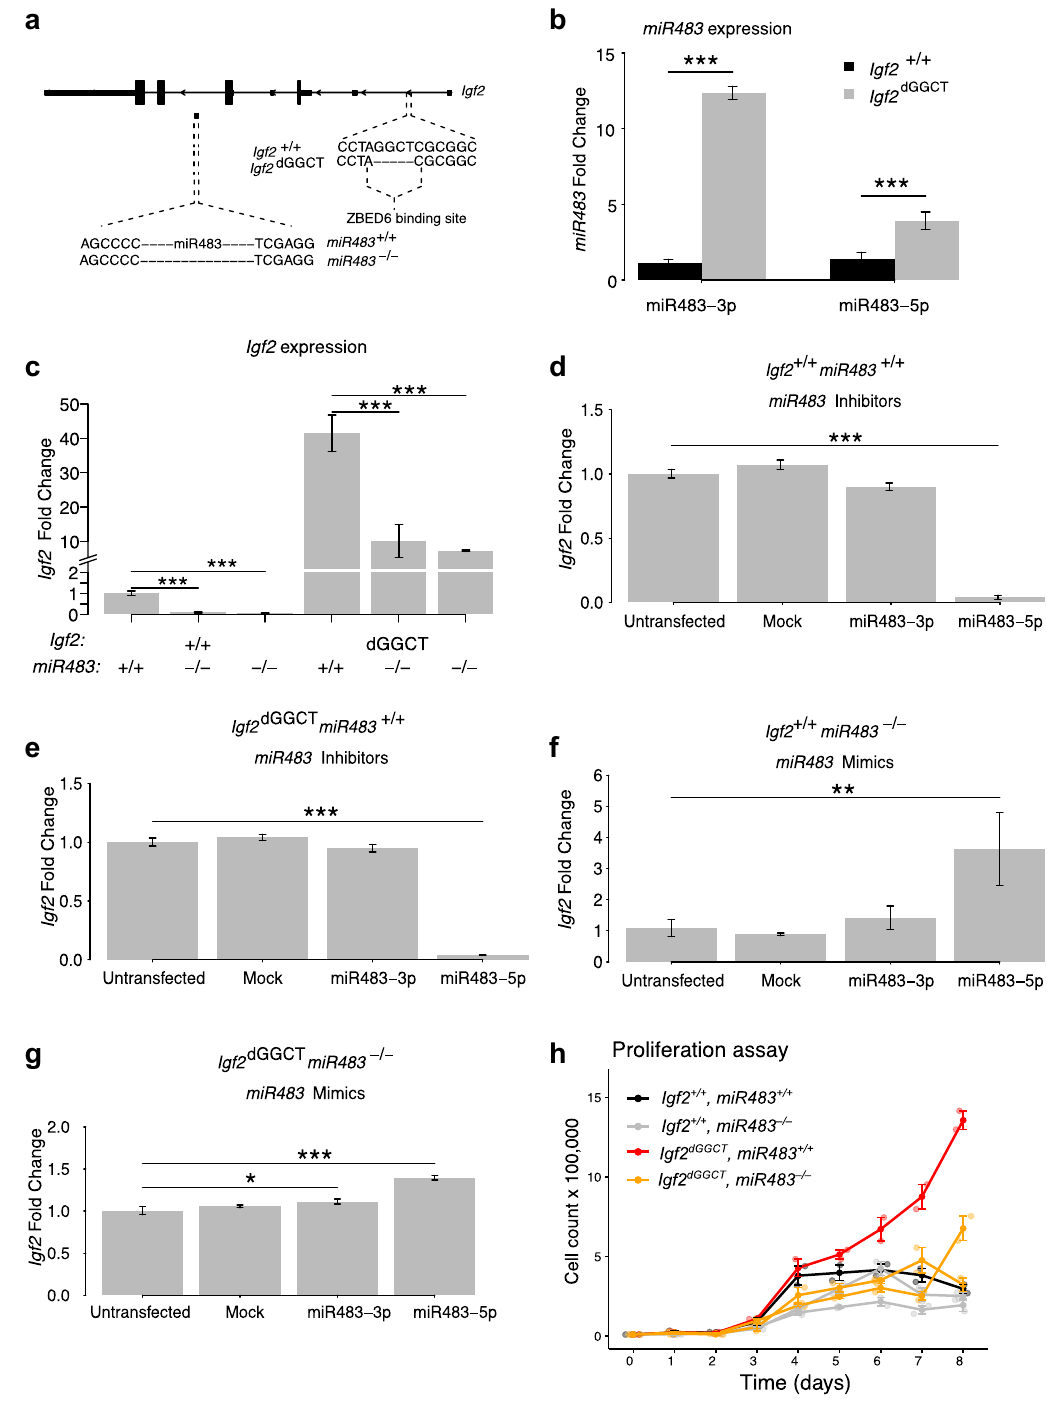
Figure 2. Disruption of miR483 and its effect on Igf2 expression in mouse C2C12 myoblast cells. ( a ) A depiction of the Igf2 locus showing the Igf2 dGGCT mutation at the ZBED6 binding site, and the miR483 sequences that were removed by CRISPR/Cas9. ( b ) qPCR analysis showing the expression levels of miR483 in Igf2 +/+ _ miR483 +/+ and Igf2 dGGCT _ miR483 +/+ cells. ( c ) The expression levels of Igf2 in Igf2 +/+ _ miR483 +/+ ,